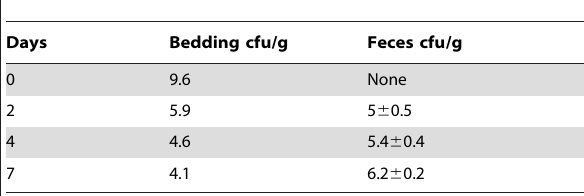
Table 1. Calves acquire cef R E. coli from bedding.